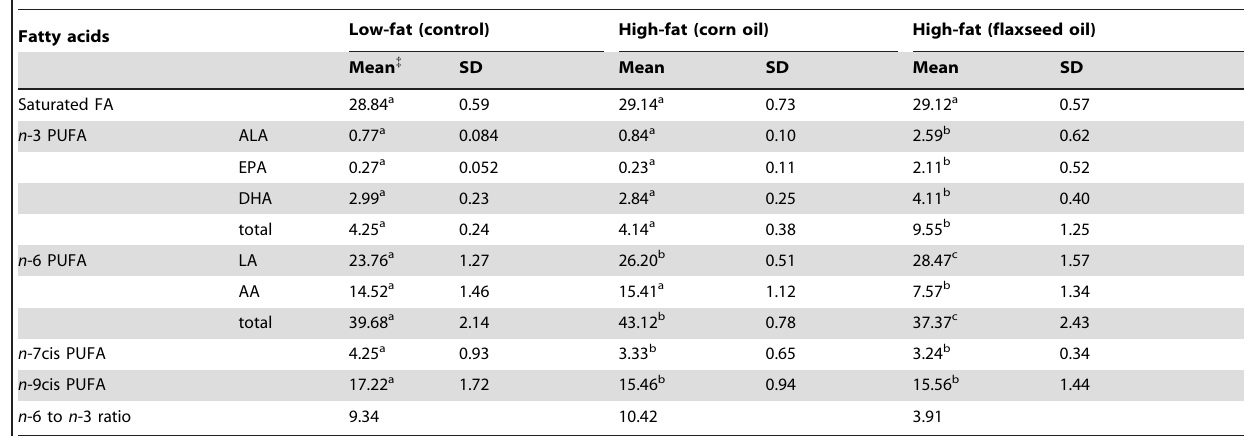
Table 2. Fatty acid profile of mouse sera { .